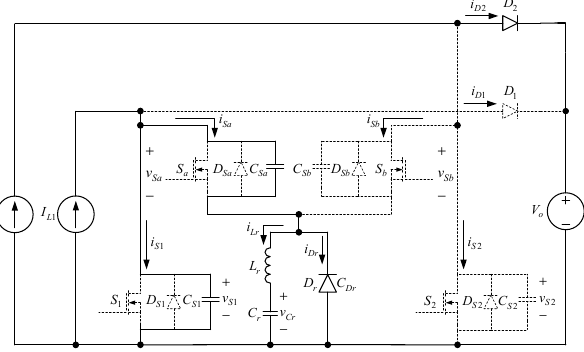
Figure 9. Current path in mode 6.